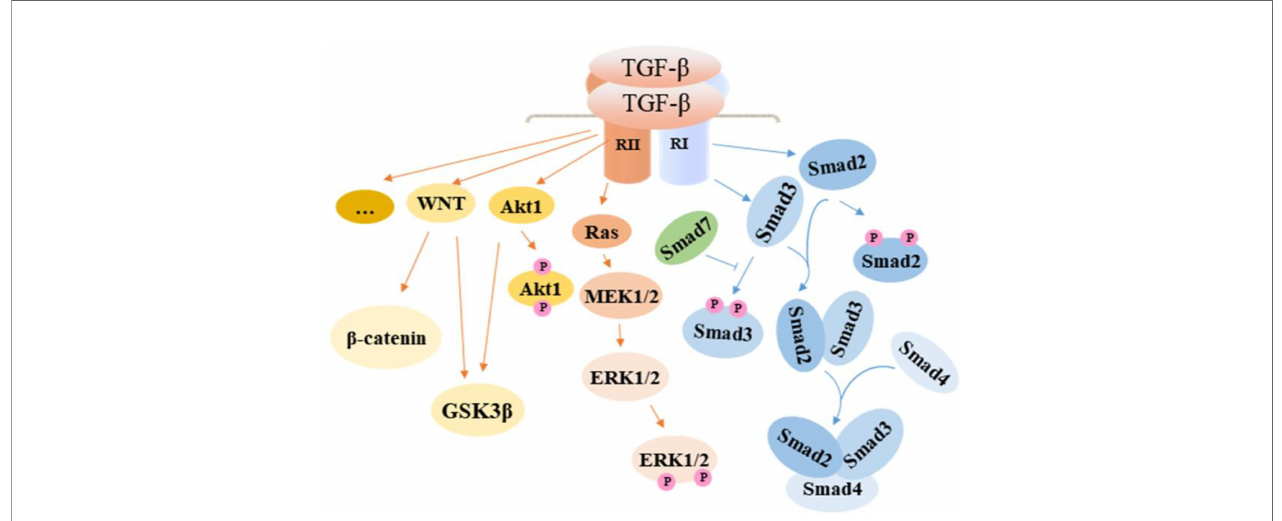
FIGURE 2 | TGF- b activated signaling pathway in intestinal fi brosis. TGF- b promotes fi brosis by regulating related cells through the activation of the canonical Smad signaling pathway and noncanonical pathway including MAPK and WNT, which contribute to the development of EMT in epithelial cells, the proliferation of fi broblasts, and transformation of fi broblasts and smooth muscle cells to myo fi broblasts. In effect, ECM is overexpressed, resulting in increased collagen deposition. TGF- b , transforming growth factor b ; Smad, drosophila mothers against decapentaplegic; Ras, rat sarcoma; MEK, methyl ethyl ketone; ERK, extracellular regulated protein kinases; GSK3 b , glycogen synthase kinase3 b